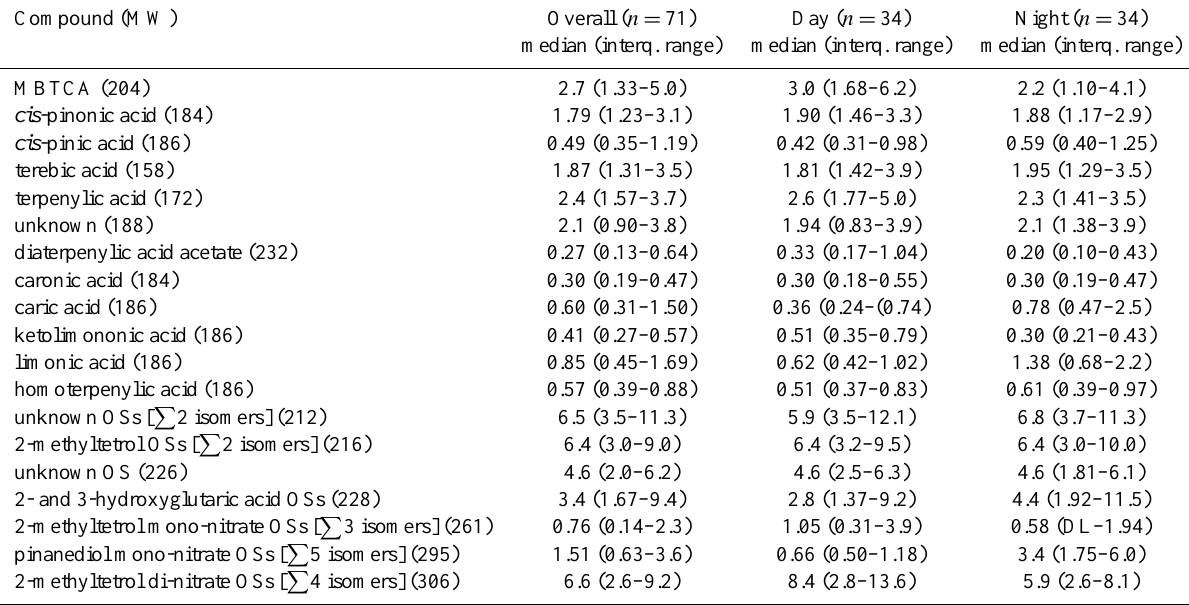
Table 2. PM 2 . 5 front filter median concentrations and interquartile ranges of terpenoic acids and organosulfates (ng m − 3